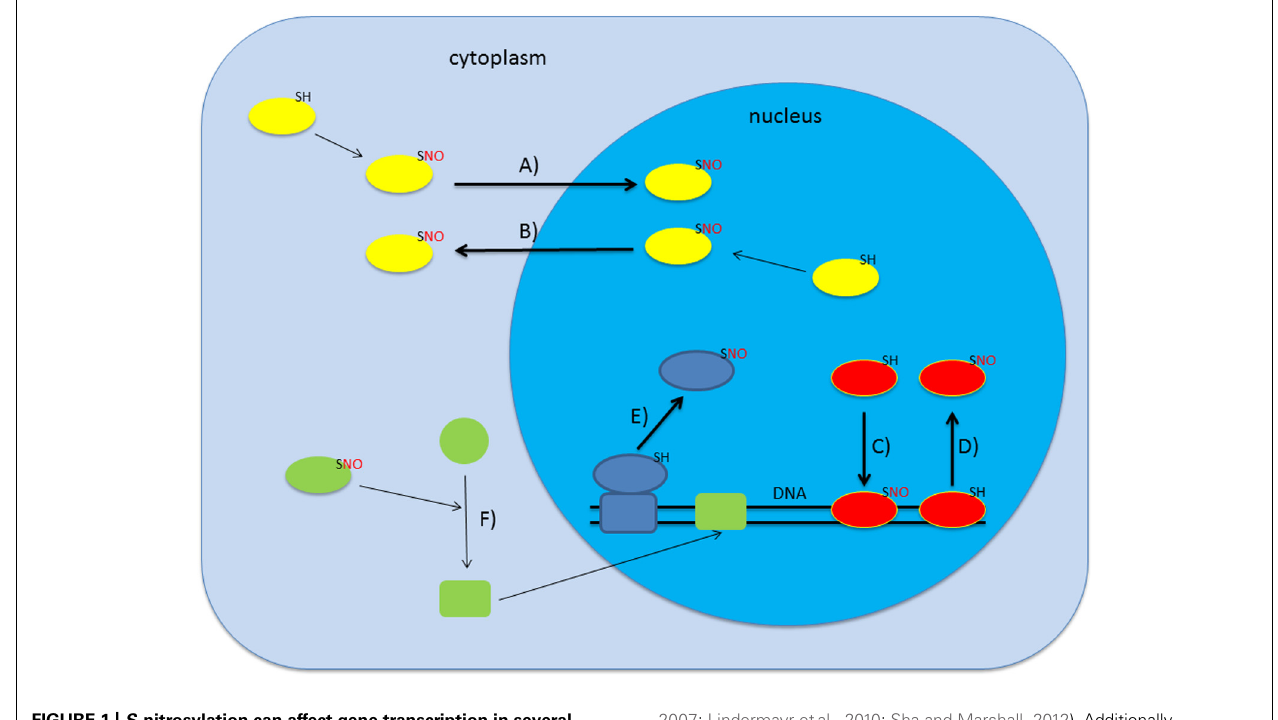
FIGURE 1 | S -nitrosylation can affect gene transcription in several ways. Upon S -nitrosylation proteins can change their subcellular localization which may lead to either import in (A) or export out (B) of the nucleus (Qu etal., 2007; Malik etal., 2010). Alternatively, S -nitrosylation is also described to alter DNA-binding activity of certain proteins ( C,D ; Serpa etal.,